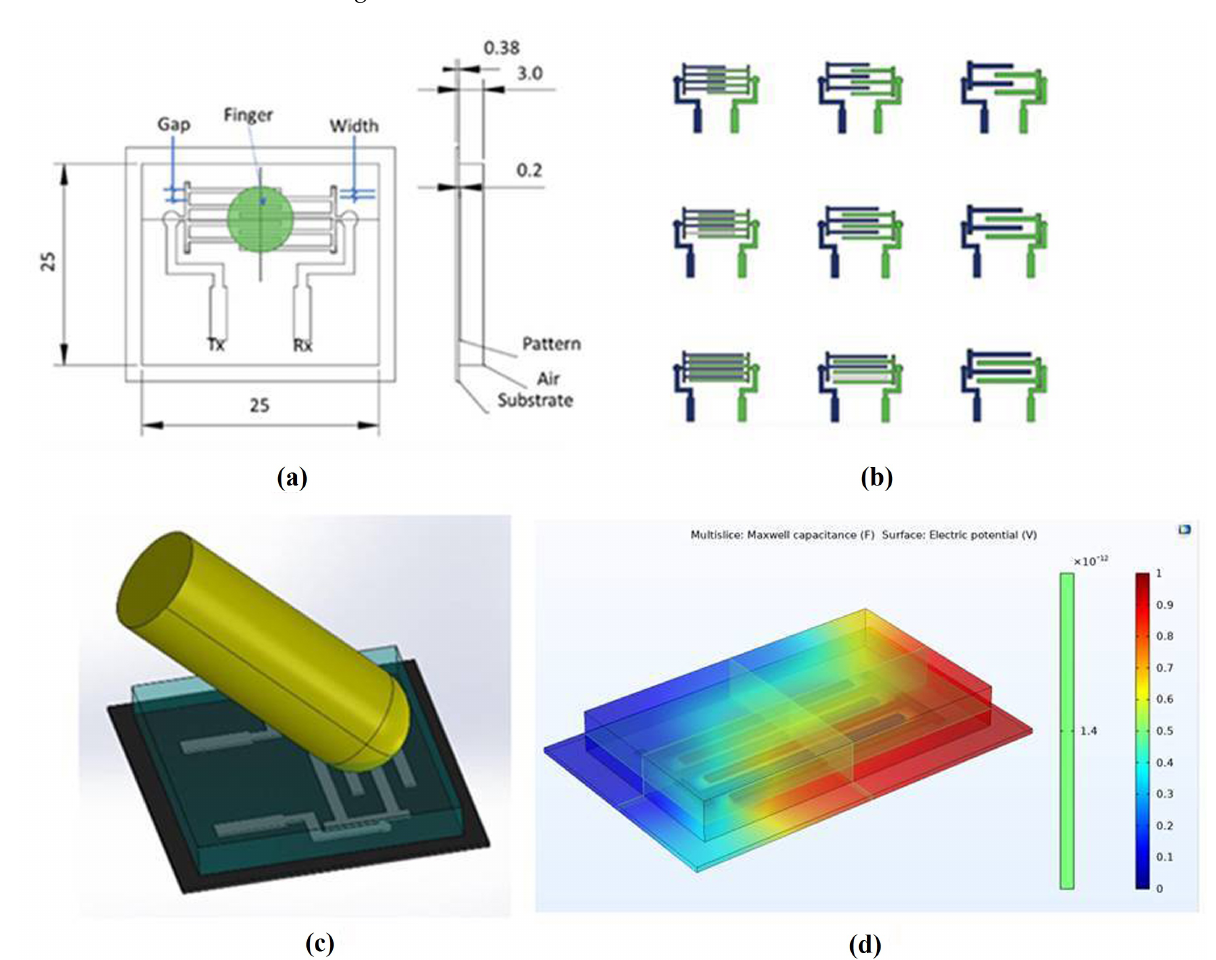
Figure 4. Design and simulation ( a ) Electrode Design ( b ) Sensor Pattern design ( c ) Parametric CAD Model ( d ) Capaci- tance/Electric